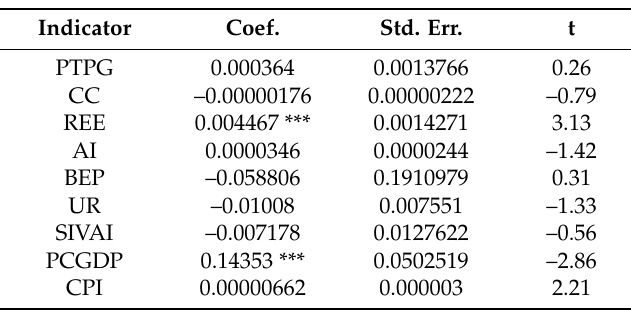
Table 3. Regression analysis of original